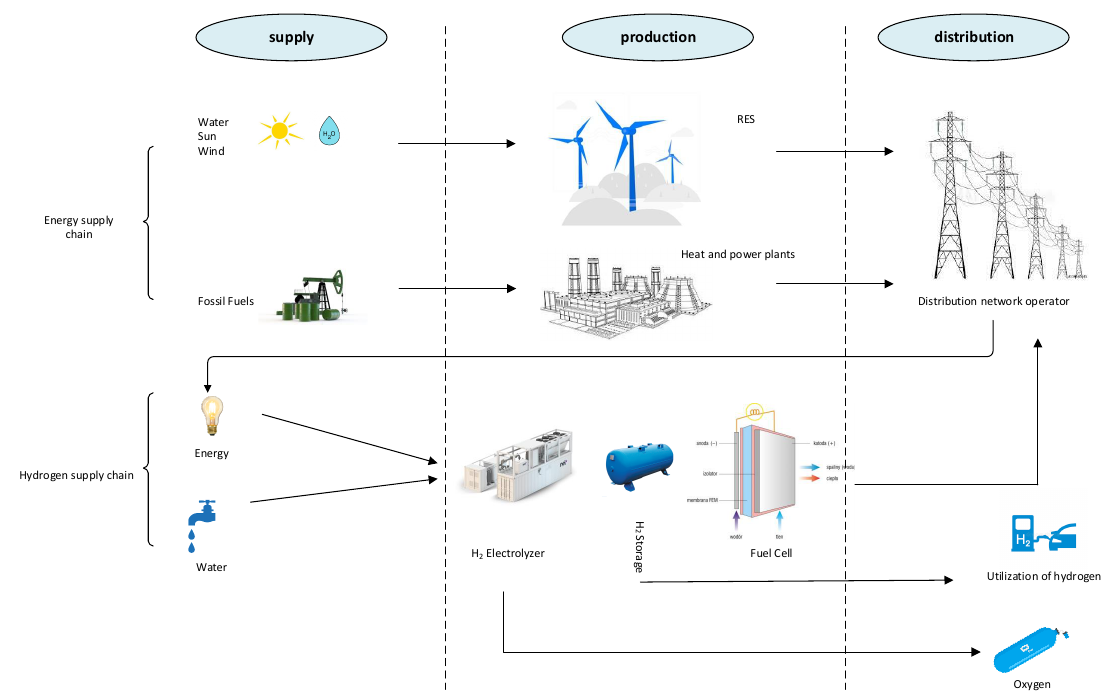
Figure 2. Energy supply chain with hydrogen supply chain. Source: own